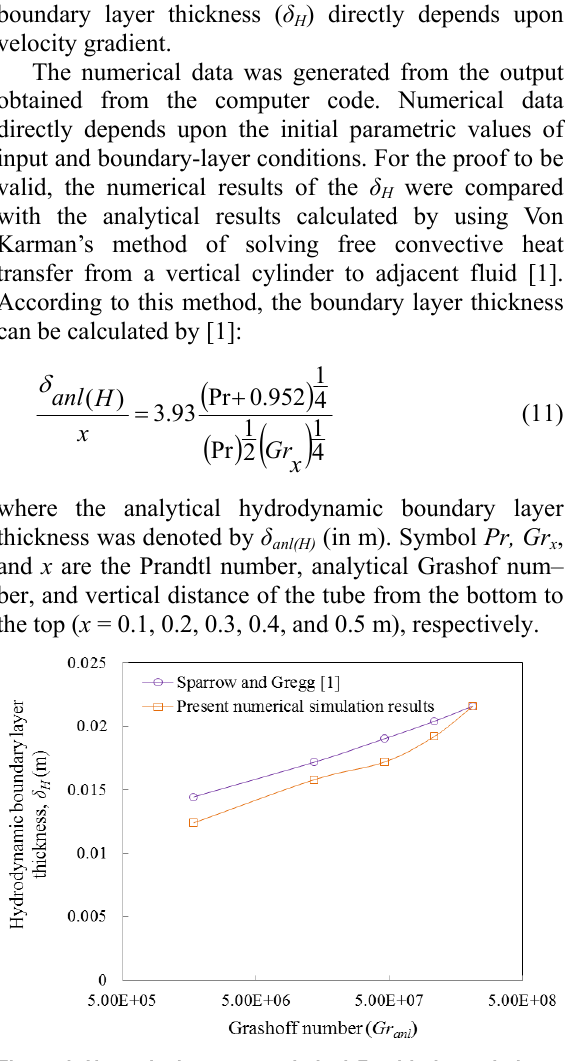
Figure 6. Numerical versus analytical δ H with the variation in Grashof number for the fluid methane at various locations along with the heated vertical